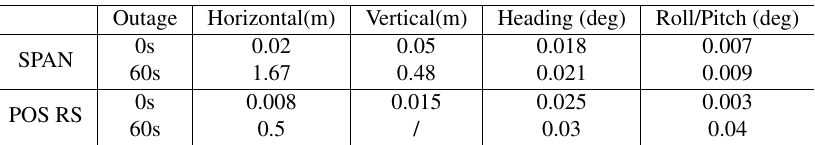
Table 2: INS accuracy specifications